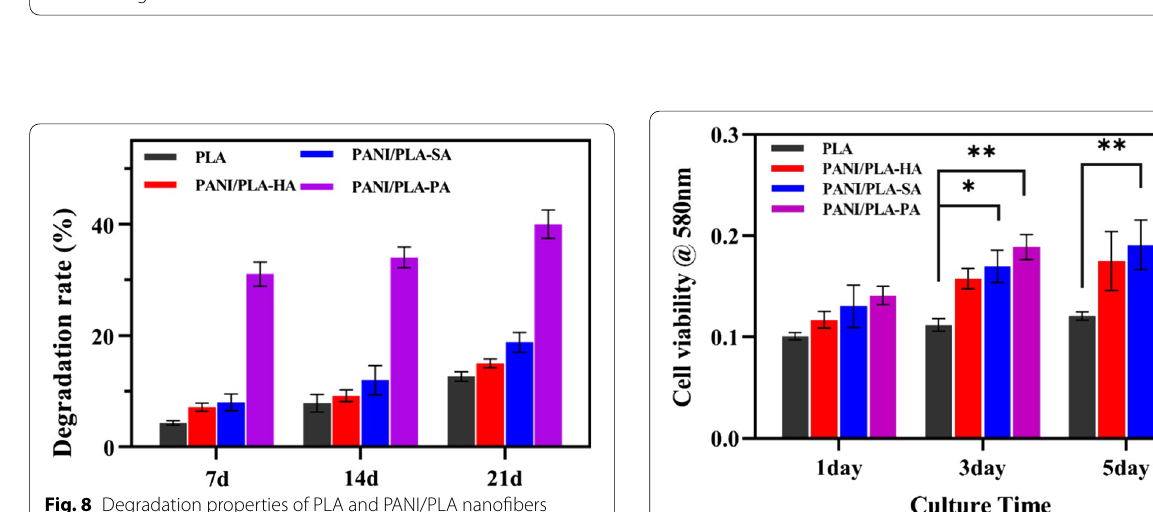
Fig. 7 XPS spectra ( a ) of prepared PANI/PLA composite nanofibrous scaffolds and the PANI/PLA-HA ( b ), PANI/PLA-SA ( c ), and PANI/PLA-PA ( d ) of the core level signal of N1s